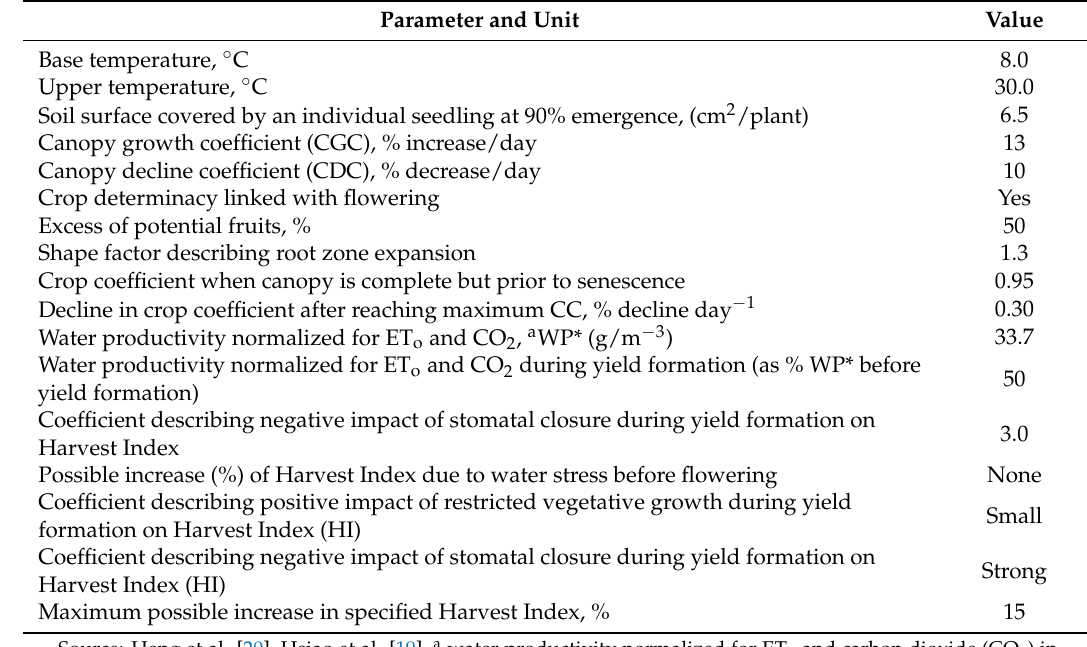
Table 3. Conservative parameters used in the